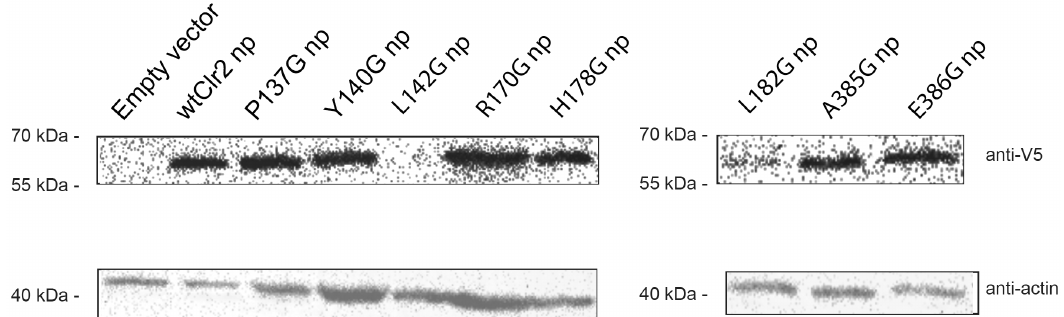
Figure 5. V5-Clr2 constructs were detected by Western blot. All the proteins were fused to a V5 tag in the N-terminus and detected using an anti-V5 antibody. The wild type Clr2 protein, wtClr2, as well as most of the point mutated versions of Clr2 could be detected when expressed from an nmt promoter (np). In all strains except L142G a protein of predicted size (63.4 kDa) was detected between the 55 and 70 kDa size markers. The mutated versions of the Clr2 protein migrated to the same position as the wild type protein and were detected by the anti-V5 antibody. Equal loading was detected using an anti-actin antibody. doi:10.1371/journal.pone.0086948.g005 PLOS ONE |